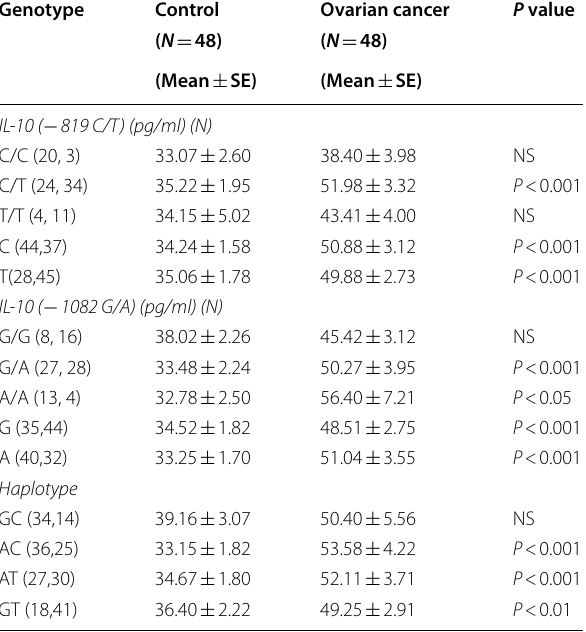
Table 4 Interleukin IL‑10 mean plasma concentrations in controls and OC patients according to gene polymorphism (1082 G/A and 819